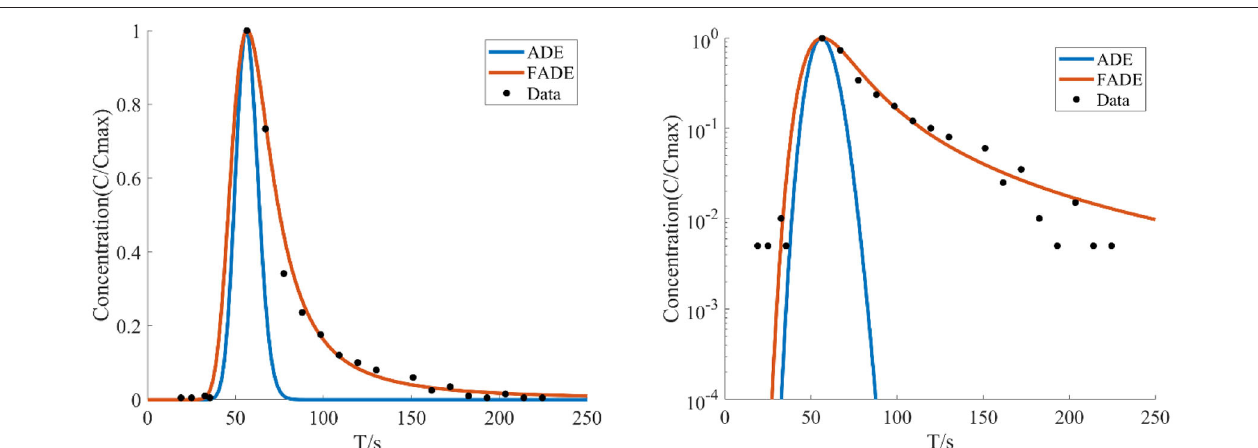
FIGURE 2 | The average flow rate is v = 13.675 mm/s, the crack width is B = 4mm, and BTCs fitted by ADE model and FADE model is